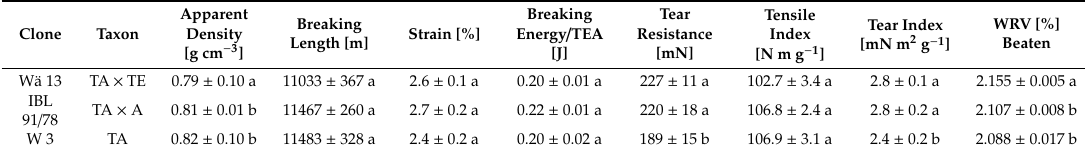
Table 6. Physical properties of paper sheets for researched clones, means ± SE and results of Tukey’s honestly significant di ff erence test. The same lowercase letters indicate statistically homogenous groups at α = 0.05 in Tukey